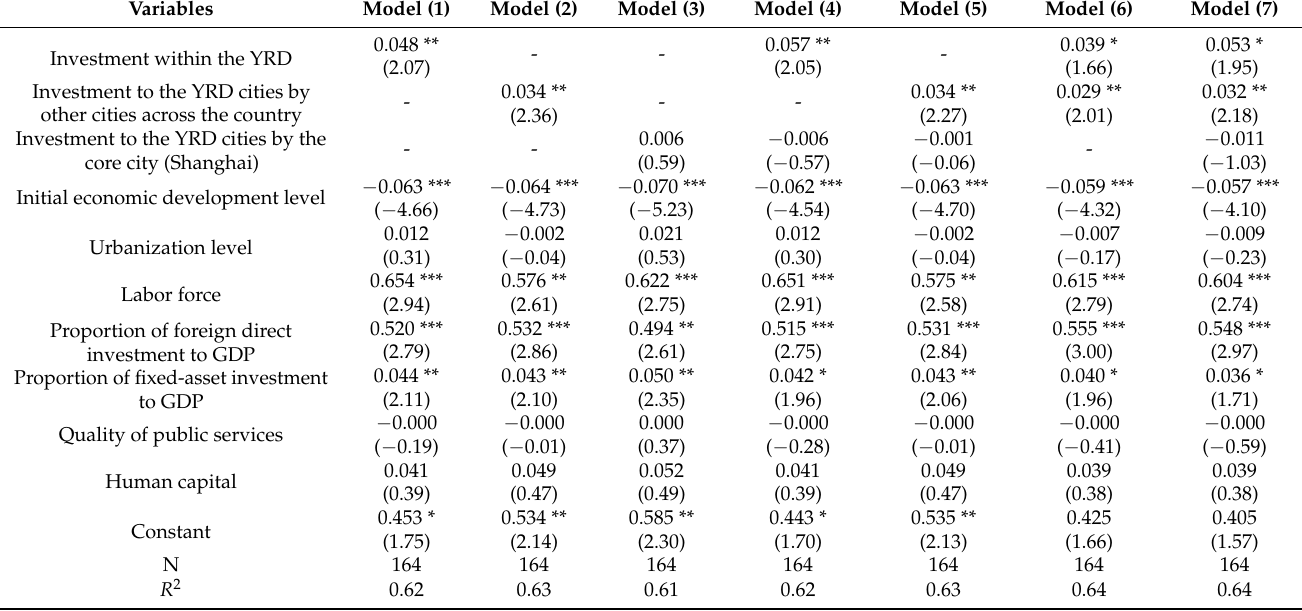
Table 2. The fixed-effect model of investment growth on urban economic